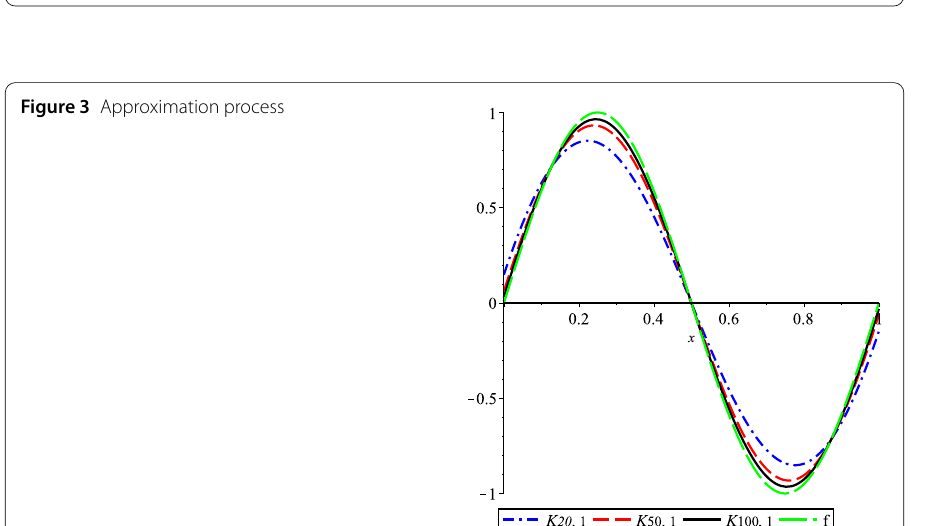
Figure 3 Approximation